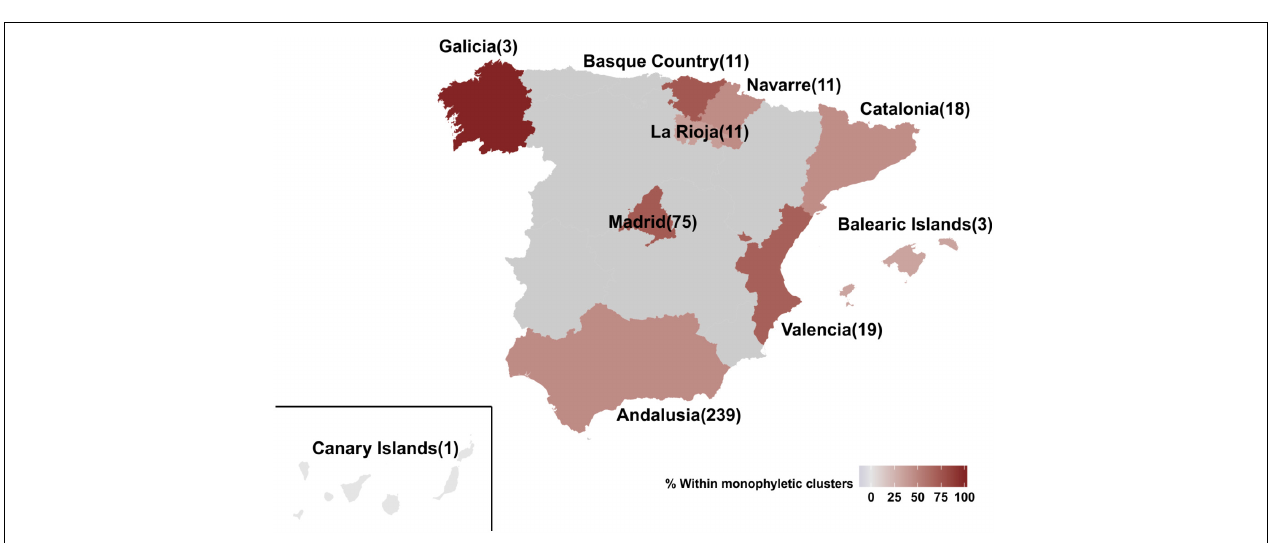
FIGURE 2 | Map of Spain representing the 10 autonomous communities from which the 391 HIV-1 CRF02_AG sequences of our study population were sampled from. Autonomous communities are colored according to the percentage of monophyletic clustering. Numbers in brackets describe the available sequences per autonomous